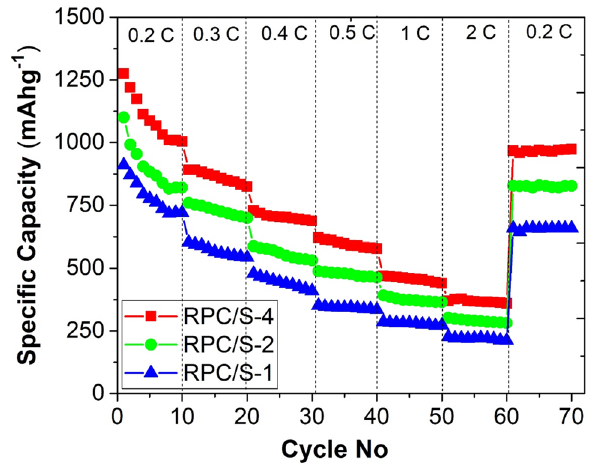
Fig. 8 Rate capabilities of RPC/S-1, RPC/S-2 and RPC/S-4 samples